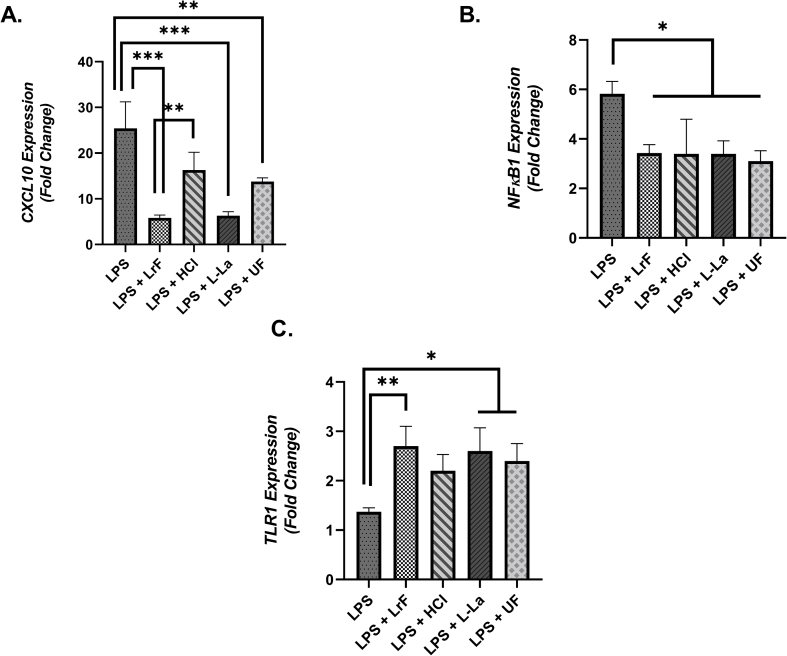
Supplemental Figure 2. Differential gene expression profiles of THP-1-derived Mθ macrophages stimulated with 125 ng/mL LPS and incubated with L. rhamnosus R0011 whole ferments or milk controls concurrently for 24 h (n = 3). A. Mean CXCL10 expression ± SEM B. Mean NFKB1 ± SEM or C. TLR1 expression ± SEM. Significance between treatment groups as determined by Tukey's one-way ANOVA is indicated as ∗ (P < 0.05), ∗∗ (P < 0.01), ∗∗∗ (P < 0.001), or ∗∗∗∗(P < 0.0001).